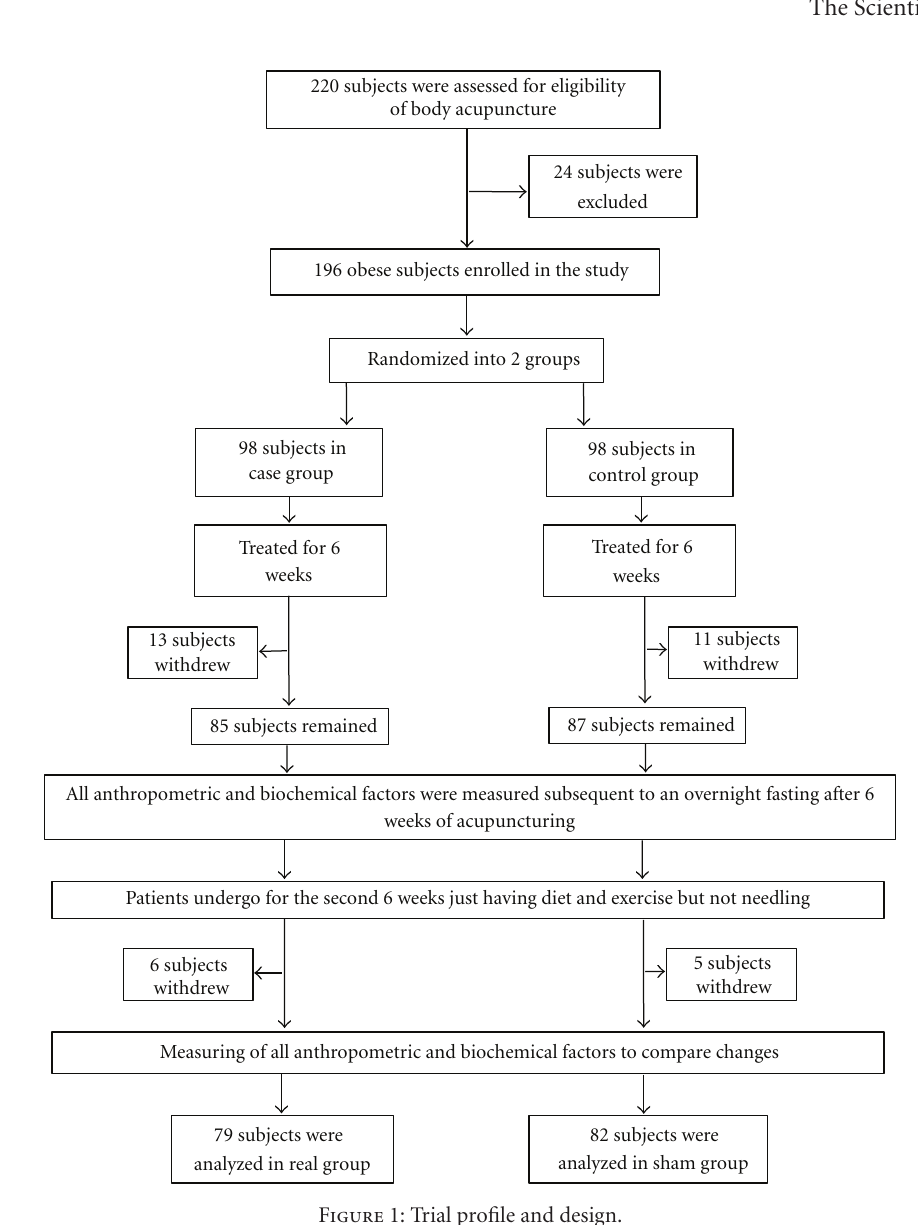
Figure 1: Trial profile and